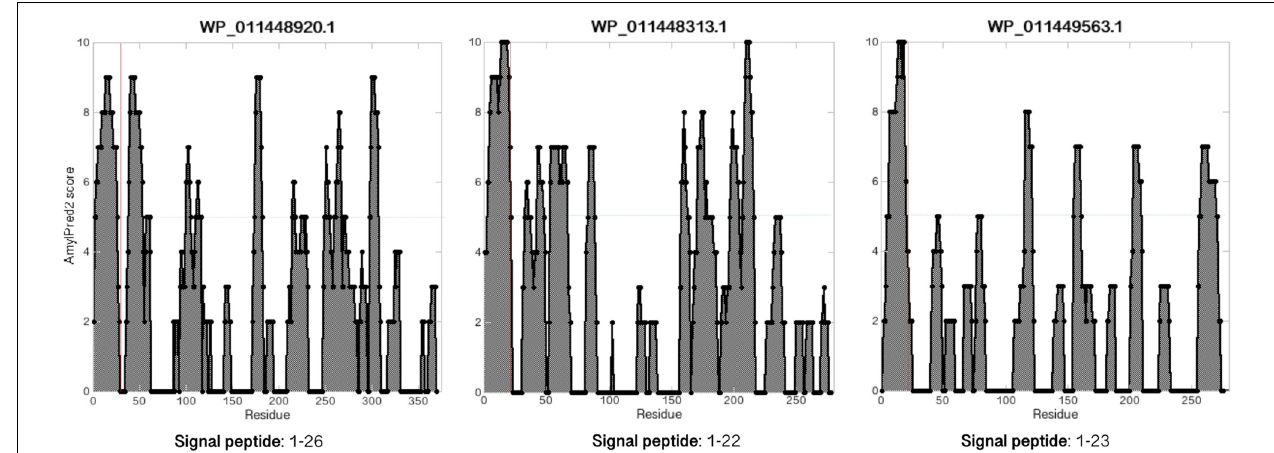
FIGURE 5 | MspA internal homologs have regularly spaced amyloidogenic regions. Analyzing the MspA (WP_011449234.1) homologs found in M. hungatei with AmylPred2 (Tsolis et al., 2013) revealed several regions of predicted high amyloidogenicity (values above the horizontal blue lines). The red, vertical lines represent predicted signal peptide cleavage site